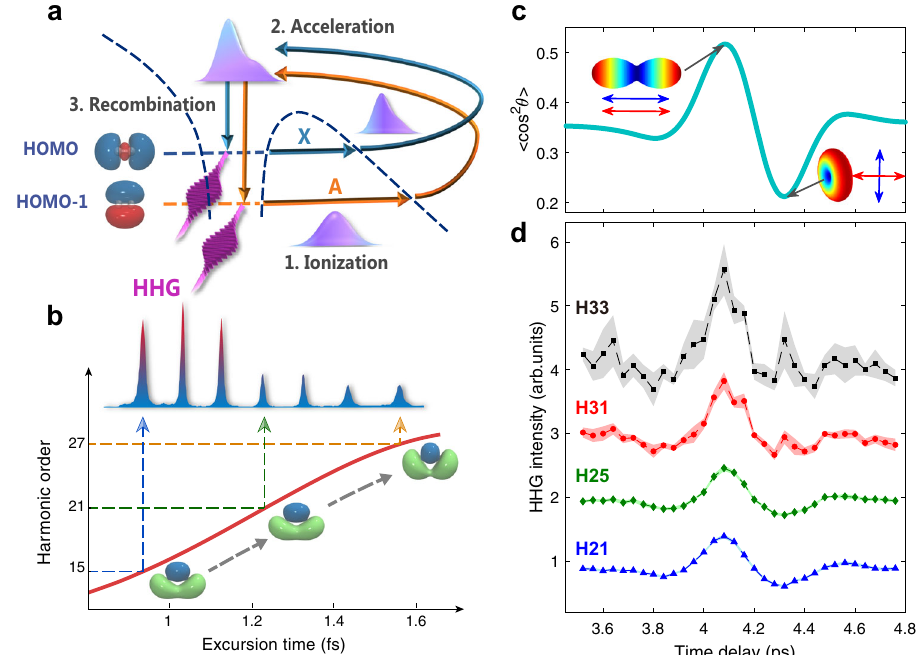
Fig.1|HarmonicgenerationfromN 2 molecule.a HHGfromeachmoleculecanbe described by the semi-classical three-step model: (1) ionization, (2) acceleration, and (3) recombination. After ionization, the molecular system is usually left in ground and several electronically excited states of the ion. In the HHG process, theseionicstatesprovidedifferentchannels(Channels X and A forN 2 )thatconnect the same initial and fi nal states of the system. The interference of harmonics of these channels leads to the eventual harmonic emission. b Time-frequency map- ping in the HHG process. For different high-harmonic orders, the freed electron spends different excursion times (the time interval between the ionization and recombination of the electron) in the continuum, providing a mapping between time and harmonic photon energy to enable temporal measurement of charge migration underlying the HHG process. Here we show only harmonics from the short-trajectory electrons due to its better phase matching in our experiment.